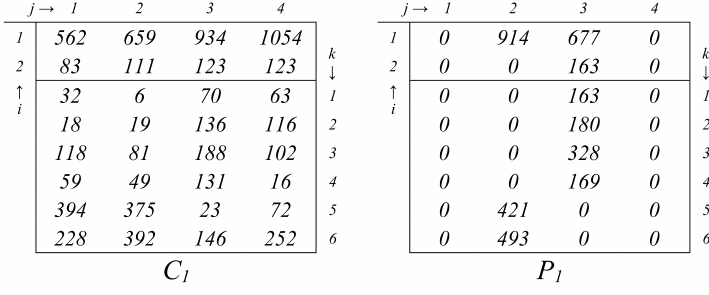
Figure 5. The representation of the estimated chromosome and the enhanced